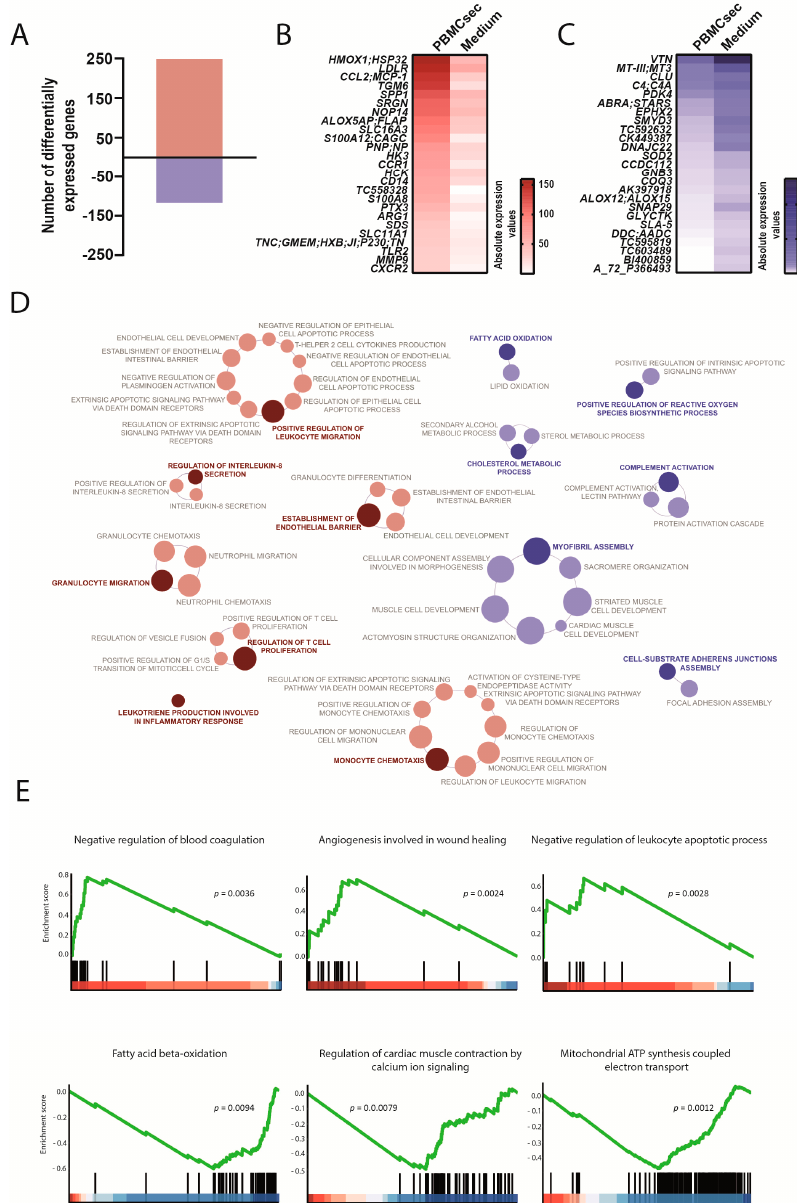
Figure 4. Transcriptional changes induced by the PBMCsec in the border zone between infarcted and remote myocardium. ( A ) Total numbers of differentially expressed genes. Red and blue indicate up- and downregulated genes, respectively, when comparing the PBMCsec versus the medium. The average fold change of n = 6 animals per group is shown. Absolute expression values of genes ( B ) up- and ( C ) downregulated by the PBMCsec compared with the medium. Colors indicate expression values. ( D ) GO terms associated with up- (red) and downregulated (blue) genes. Each circle represents one term. Circle sizes indicate p -values. Overarching terms within a group are highlighted in bold. ( E ) GSEA of up- (upper panel) and downregulated (lower panel) genes by the